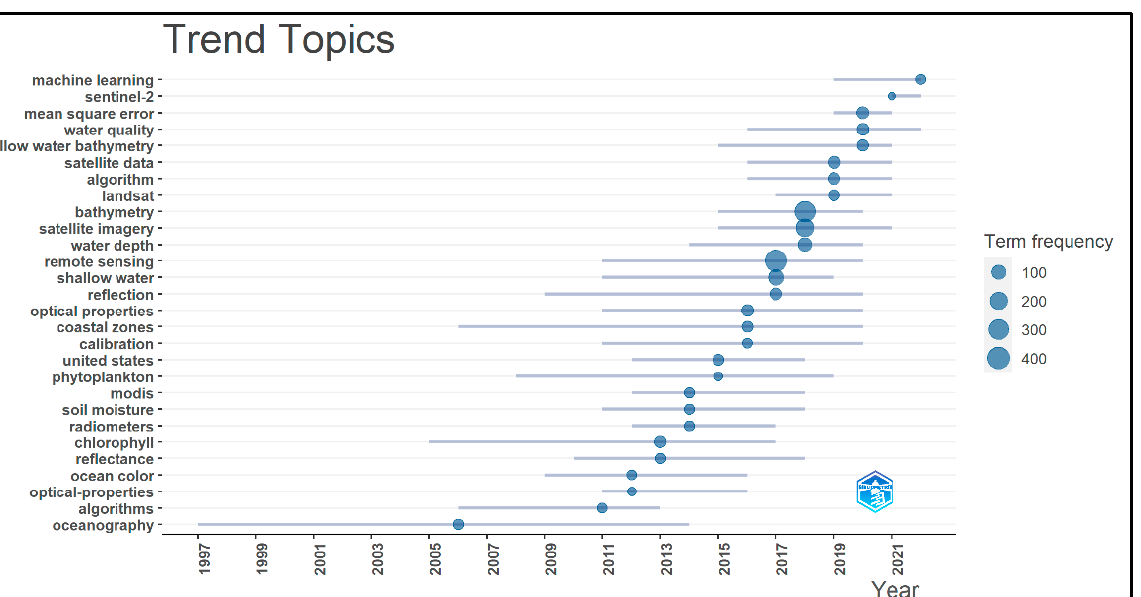
Figure 16. Word cloud of fifty most-occurring Keywords Plus for SDB (WoSCC and Scopus data- bases, from 1977 to 2022). 4. Discussion By analyzing the scientific production dealing with the SDB method, we can con- clude that we can divide it into three phases (Figure 17): 1.